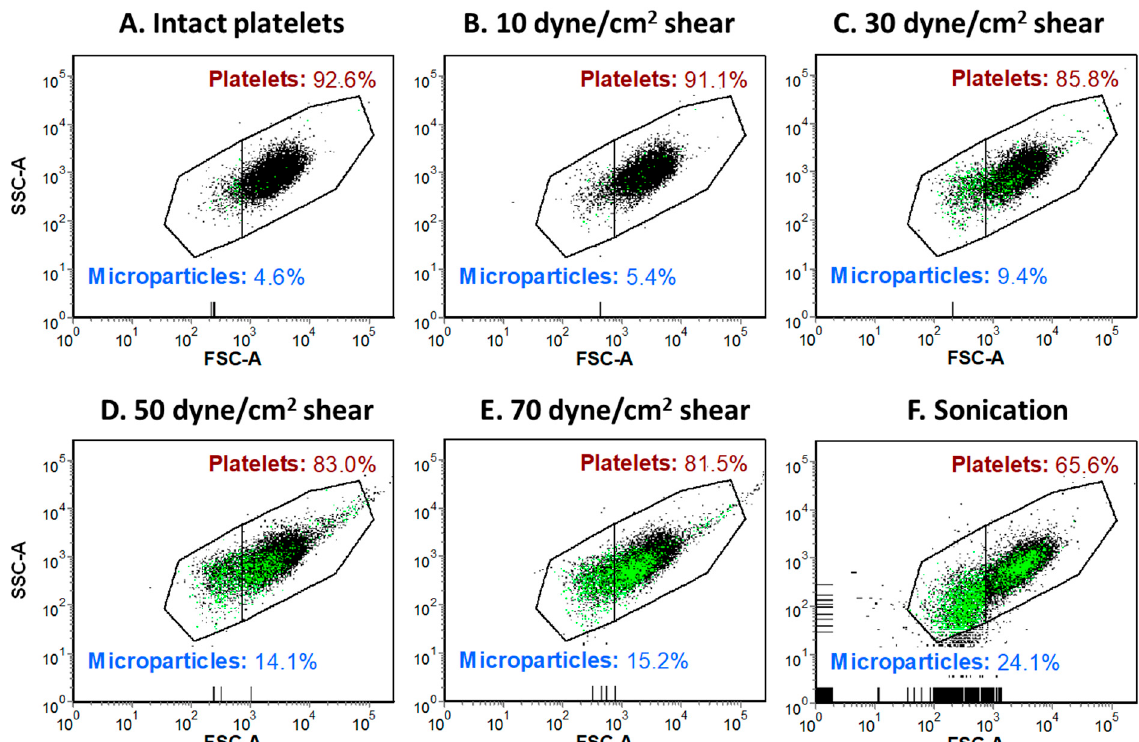
Figure 3. Platelet exposure to shear stress and sonication induces increased generation of platelet- derived microparticles (PDMPs). Illustrative dot diagrams of α IIb+ platelets and α IIb+ micropar- ticles gated based on their forward and side scatter characteristics ( A – F ): ( A )—intact platelets, ( B – E )—sheared platelets, ( F )—sonicated platelets. Black dots—CD41+ platelets or microparticles. Green dots—CD41+/annexin V+ double positive microparticles. FSC-A—forward scatter amplitude. SSC-A—side sca tt er amplitude.